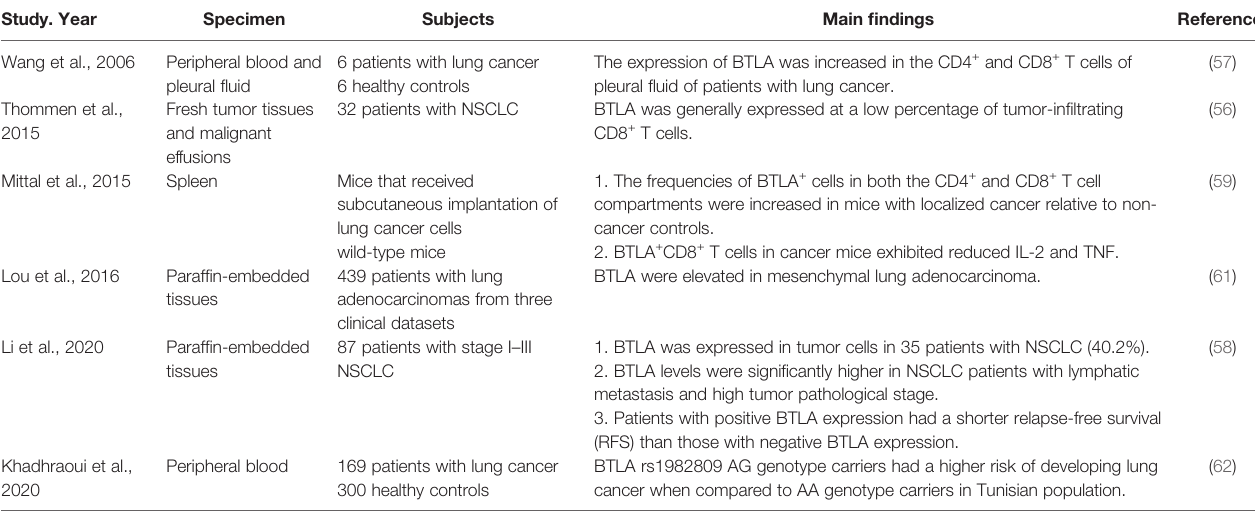
TABLE 5 | The function of BTLA in lung